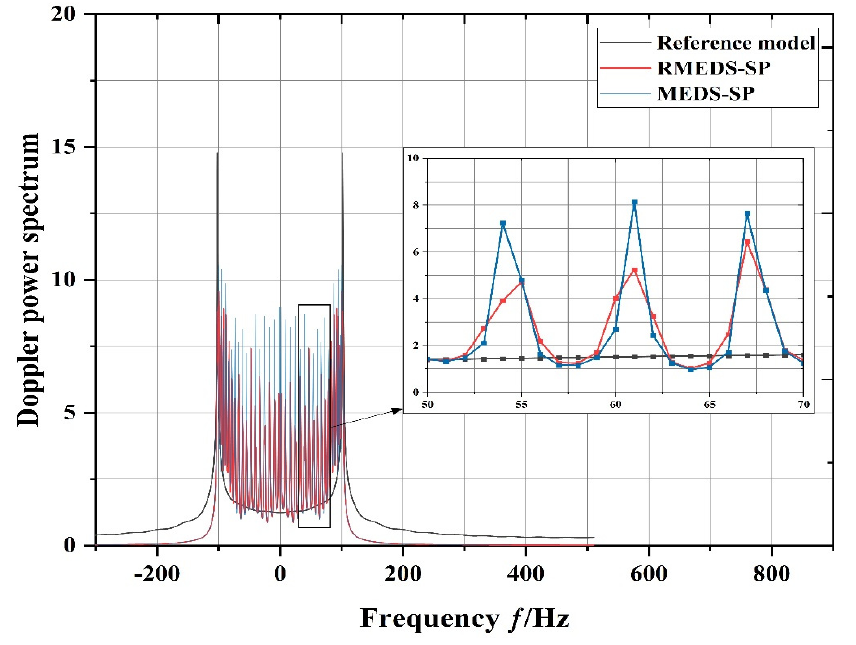
Figure 11. DPS of MEDS-SP and RMEDS-SP.